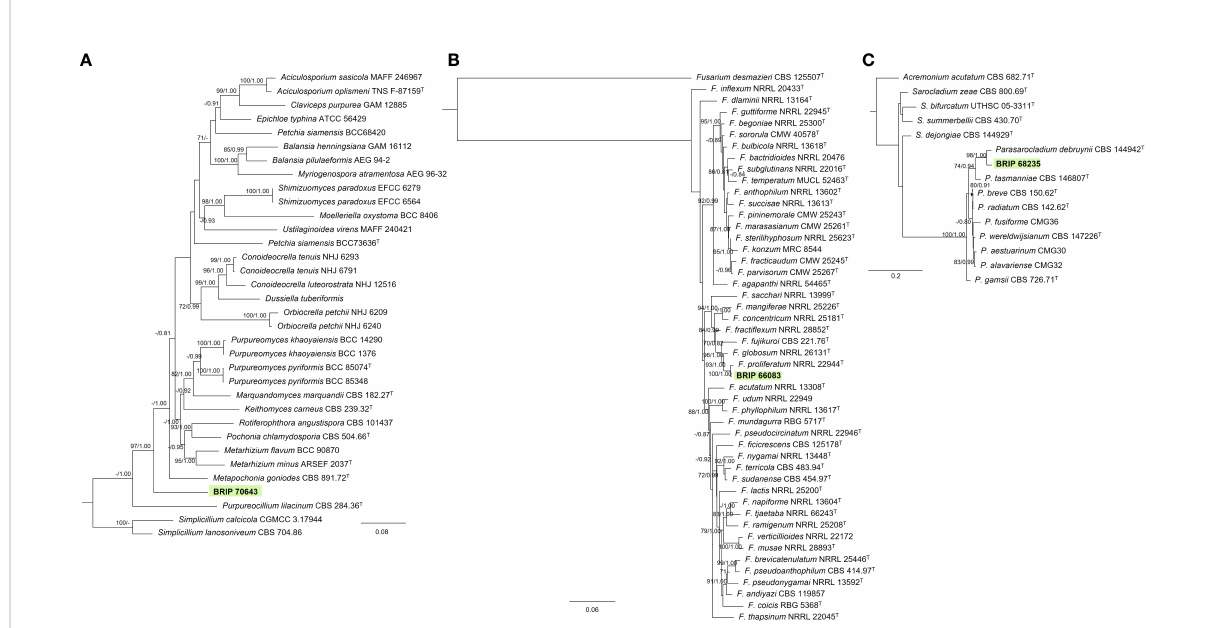
FIGURE 8 Phylogenetic trees inferred from RAxML analyses of strains in Hypocreales based on concatenated alignments of (A) rpb2 , tef1- a and LSU sequences of related genera from Clavicipitaceae; (B) ITS, LSU, rpb2 , tef1- a and tub2 sequences of related species from the Fusarium fujikuroi species complex (Nectriaceae); and (C) ITS, LSU, tub2 sequences of related genera from Sarocladiaceae (Hypocreales). RAxML bootstrap (bs) values greater than 70% and Bayesian posterior probabilities (pp) greater than 0.8 are given at the nodes (bs/pp). In bold font is the isolate from this study, and ex-type strains are indicated with T